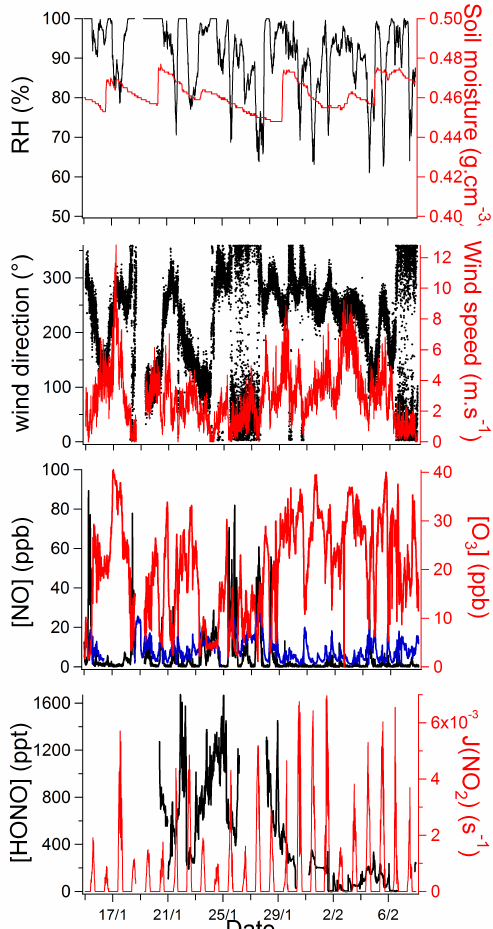
Fig. 3. 10min data of relative humidity, soil moisture measured at 5cm below ground level, wind direction, wind speed, NO x , O 3 , HONO and J (NO 2 ) during the MEGAPOLI winter field campaign at the SIRTA observatory, 15 January–7 February